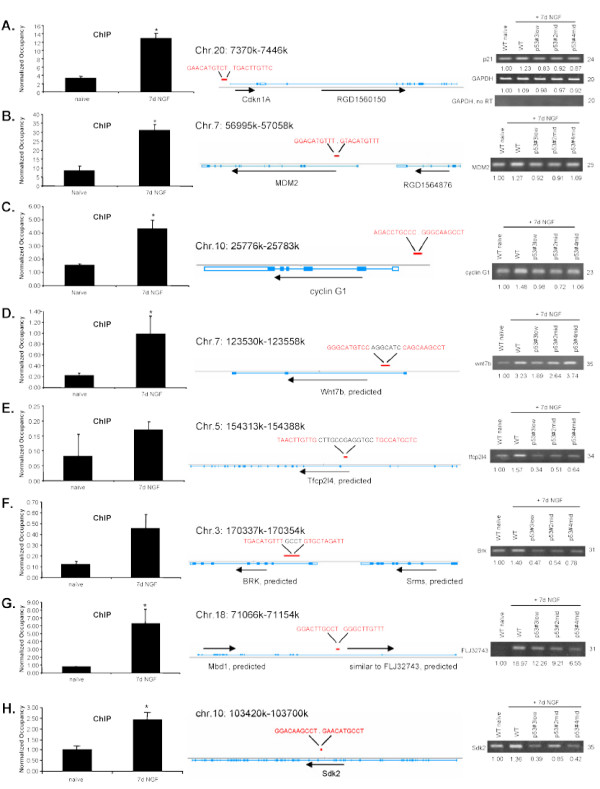
p53-dependent induction of target genes. Panels A-H show site-specific qPCR ChIP results on left with standard deviation, where significance at p ≤ 0.05 is designated by an asterisk (*). Center tile depicts gene map of predicted p53 binding site location and the sequence relative to annotated genes, along with exon structure and direction of transcription as per NCBI MapViewer conventions. Right tile represents RT-PCR gel image of each mapped target gene. RT-PCR analyses were performed multiple times for each target gene and gel images are representative of consistent expression levels. mRNA levels of each gene in wild-type naïve PC12 cells were compared to 7-day NGF (50 ng/mL) differentiated wild-type and three anti-p53 shRNA expressing PC12 cells (p53#3low, p53#2mid, p53#4mid). ImageJ quantitation, normalized to naïve RNA levels, is depicted under each band, while PCR cycle number is depicted on right of gel image. GAPDH expression levels are shown in A and represent a typical loading control along with no-RT negative control.